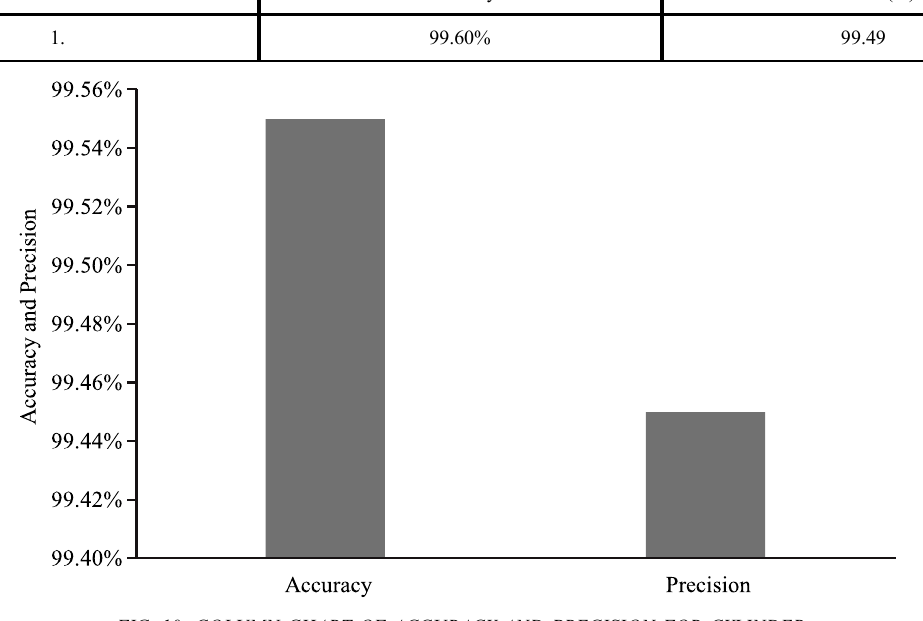
FIG. 10. COLUMN CHART OF ACCURACY AND PRECISION FOR CYLINDER